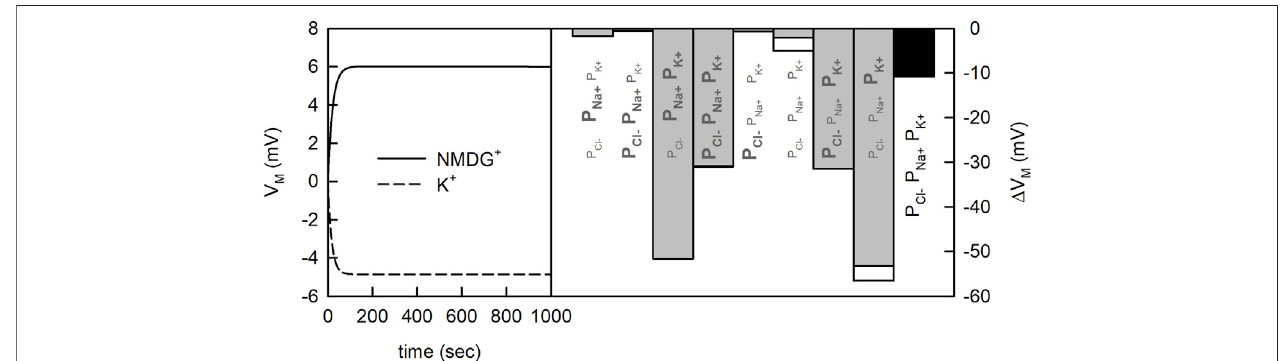
FIGURE 3 | Membrane potential generated by the net fl ux of charged particles. Vesicle assay kinetics simulated for two different experimental conditions. At both conditions,200 mMNaClwaspresent outsidethevesicle.Inside thevesicletherewaseither200 mM KClor200 mMNMDG + Cl − .Inthesimulation 20 mMHEPES, was present inside and outside the vesicle and the pH was set to 7.5. Left panel Time course of the change in membrane potential ( V M ) for a set of passive membrane permeabilities (i.e., P Cl − (cid:2) 5 · 10 − 13 m / s , P K + (cid:2) 3 · 10 − 13 m / s , P Na + (cid:2) 1 . 5 · 10 − 13 m / s ). Right panel Differences in transmembrane potentials between the two different experimental conditions for permutations of maximal and minimal P M values of Cl − , Na + and K + reported in the literature (grey bars) (bold values in Table 1 ) as well as our exemplary set (black bar). Minimal P M values are indicated using smaller font size, maximal P M values using bold letters. The effect of P NMDG is shown with empty white bars. Δ V M was de fi ned as the maximal difference between V M,K + − V M,NMDG + .